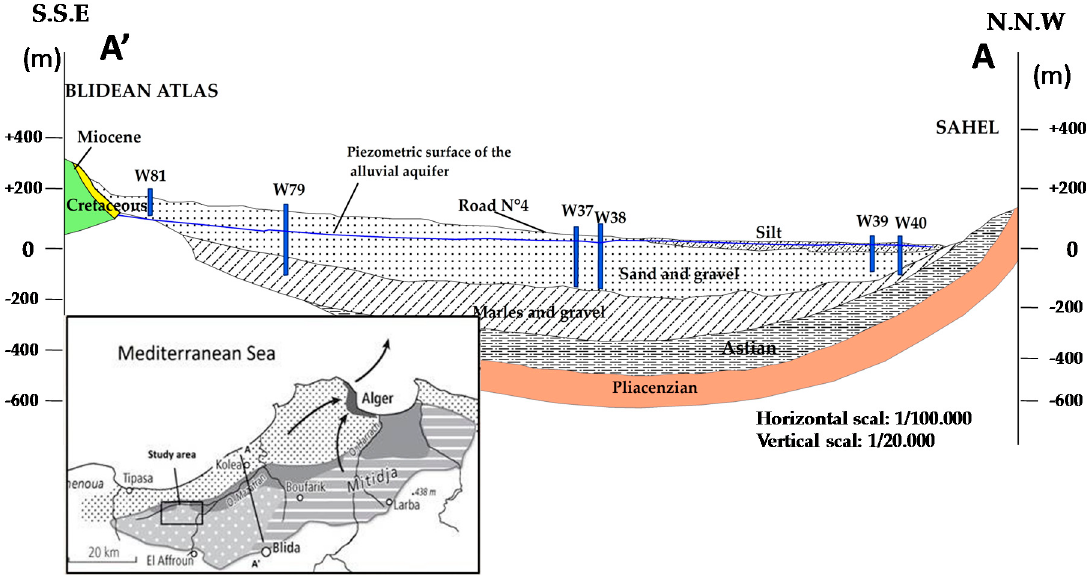
Figure 4. Geological cross section of Sahel and the Blidean Atlas (AA’) [20].